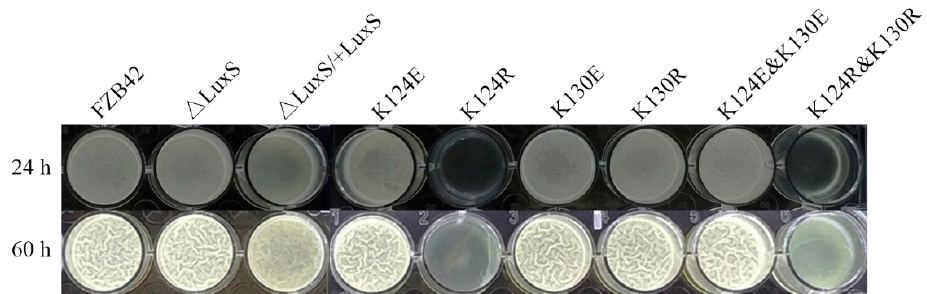
Figure 2. Pellicles formed by FZB42 WT and its mutants grown in LBGM for 24 h and 60 h.